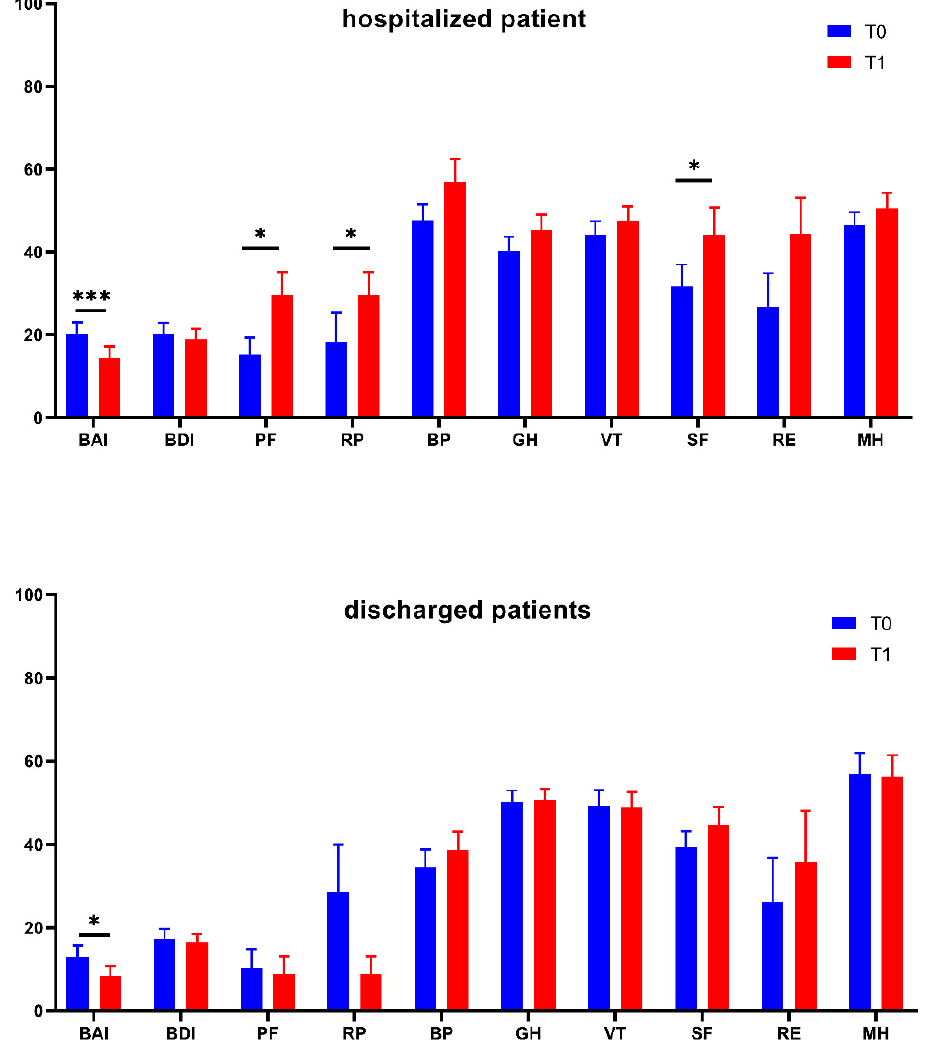
Figure 5. Evolution of anxiety, depression, and Quality of Life in patients between T0 (at least 1 month after the hospitalization) and T1 (one month after T1). BAI: Beck Anxiety Inventory; BDI: Beck Depression Inventory; PF: SF36—Physical Functioning; RP: SF36—Role-functioning Physical; BP: SF36—Bodily Pain; GH: SF36—General Health; VT: SF36—Vitality; SF: SF36—Social Functioning; RE: SF36—Role-functioning Emotional; MH: SF36—Mental Health. The asterisks indicate a statistically significant difference (* p < 0.05; ** p < 0.01).